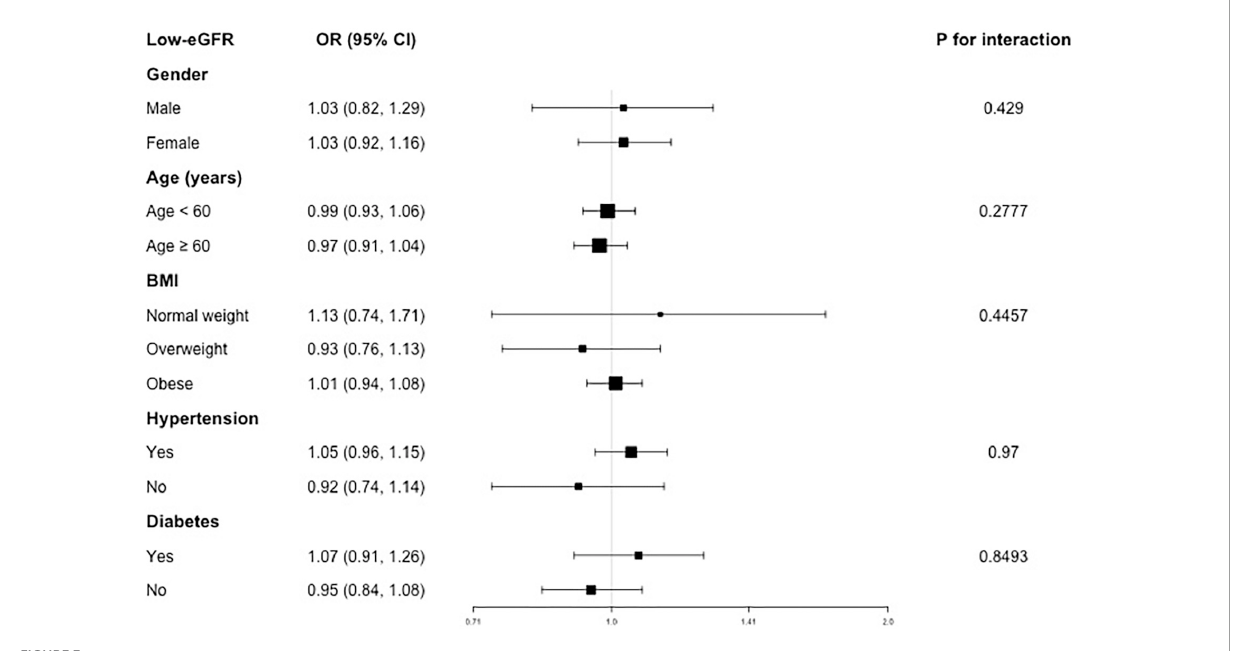
FIGURE3 Subgroup analysis for the association between VAI and